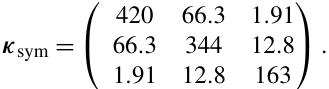
Figure 15. Selection of the subvolumes in the S3 CT data set for ad- ditional permeability tensor simulations. Each subvolume has a size of 350 voxels cubed, while the full volume has a size of 1200 voxels